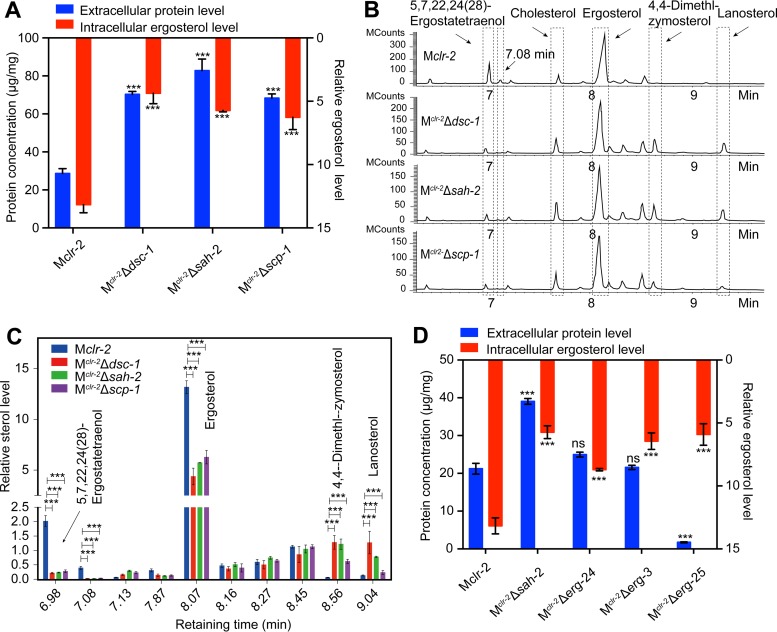
SREBP-regulated ergosterol biosynthesis pathway in N. crassa. (A) Total secreted protein level and intracellular ergosterol levels in a 48-h VMM culture of the strains indicated after a shift from a 16-h VMM culture. (B) GC-MS chromatogram of sterol extracts from the strains indicated. MCounts, mega counts, indicating the intensity (abundance) of the signal for each peak. (C) Quantified level of each sterol component in extracts of Mclr-2, Mclr-2 Δdsc-1, Mclr-2 Δsah-2, and Mclr-2 Δscp-1 cultures. The relative level of each sterol component was normalized by cholesterol internal standard. (D) Total secreted protein level and intracellular ergosterol levels of the strains indicated under the same conditions as for panel A.